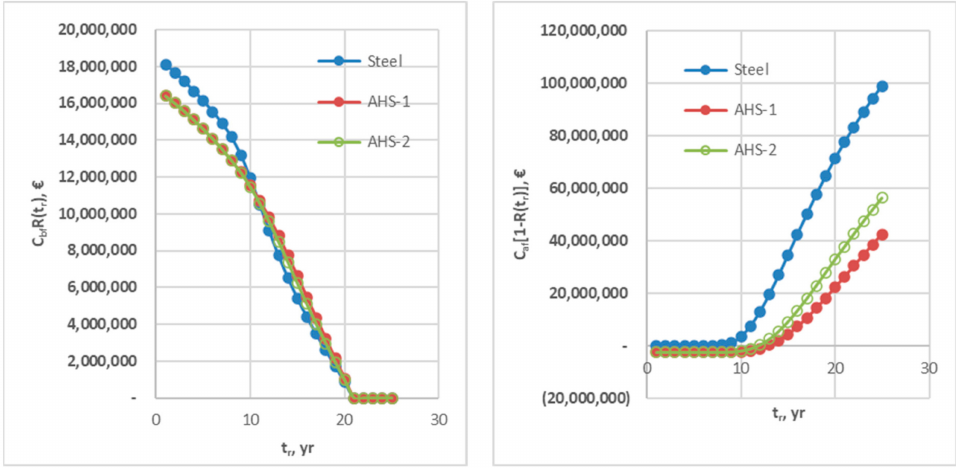
Figure 9. Cost of repair before failure ( left ) and after failure ( right ).